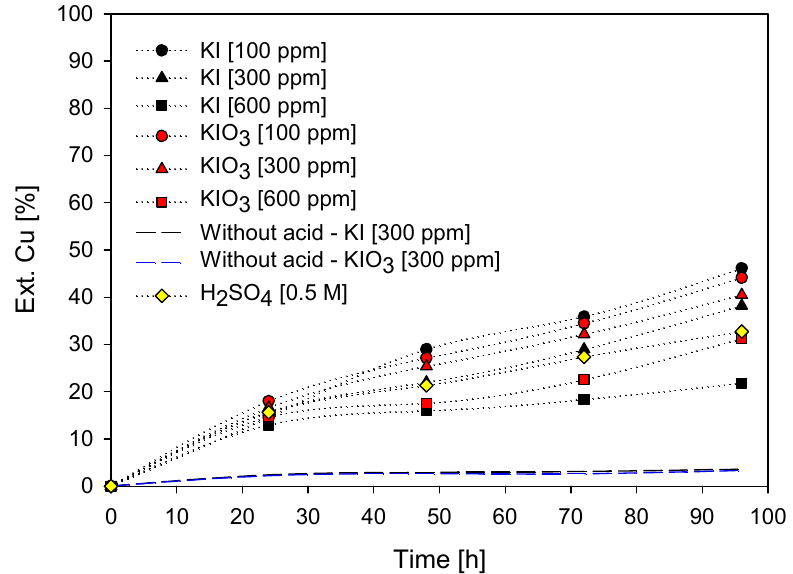
Figure 10. % Cu. Ext. vs time of leaching [Conditions: H 2 SO 4 = 0.5 M (unless otherwise indicated), 45 °C, 50 g of sample in 1000 mL of seawater solution, 450 rpm].